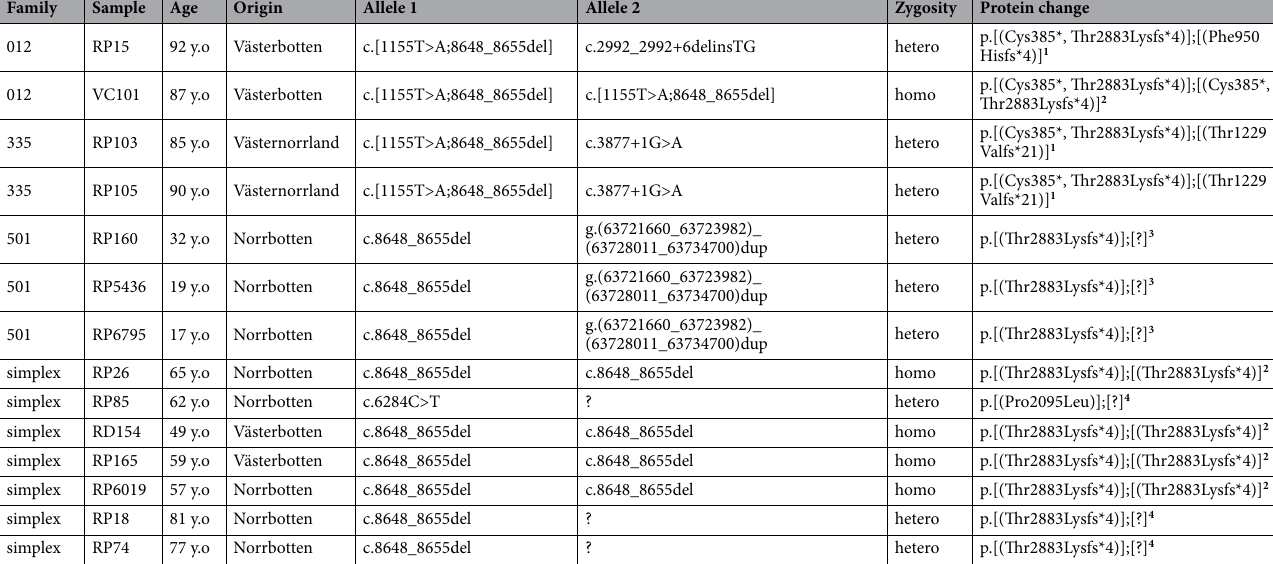
Table 1. EYS variants in arRP patients in the northern part of Sweden. 1 Two variants are present on one allele and another variant is present on the second allele in this patient. 2 Pathogenic variants were present on both alleles in this patient. 3 Duplication breakpoints remain unknown. 4 Only one likely pathogenic variant was found. All sequence positions are denoted according to NM_001142800.1 (human reference genome GRCh38/